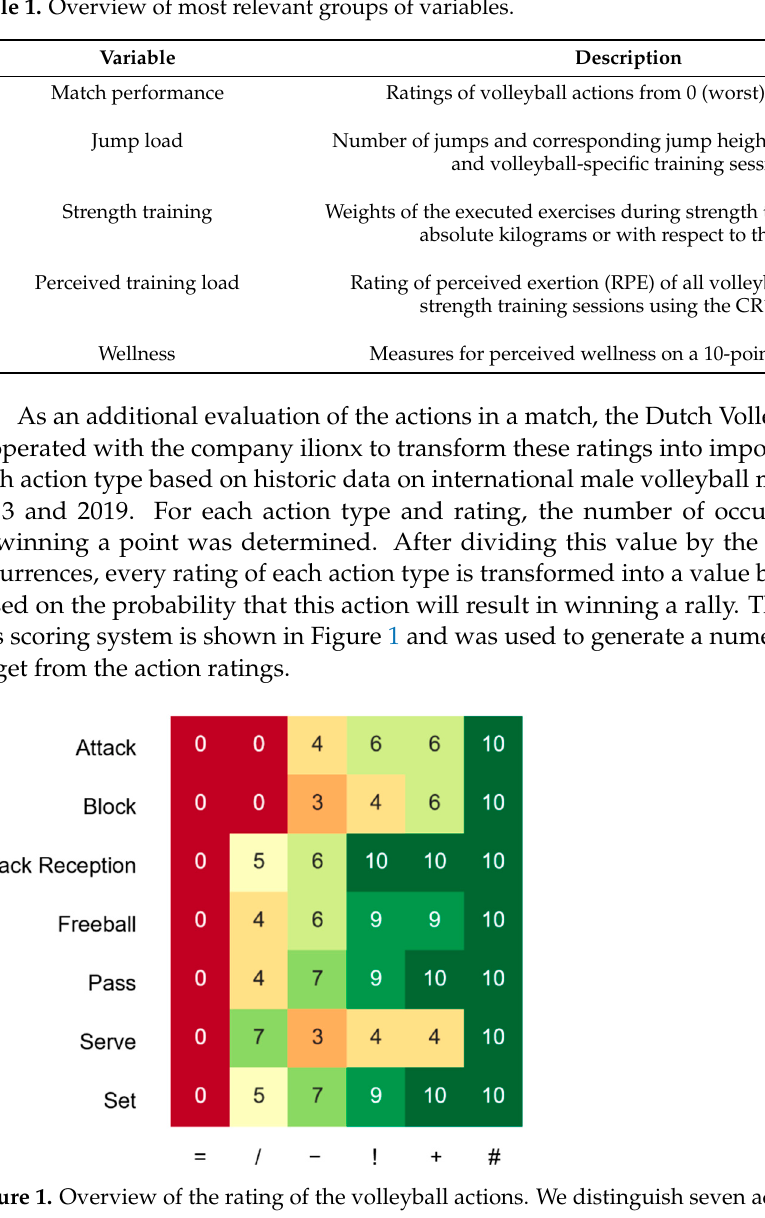
Figure 1. Overview of the rating of the volleyball actions. We distinguish seven action types and six ratings. Each combination of action type and rating is transformed into a score between the worst (0) and best (10) performance using the probability of winning a rally after performing an action with a certain rating based on data of male volleyball matches from 2013 to